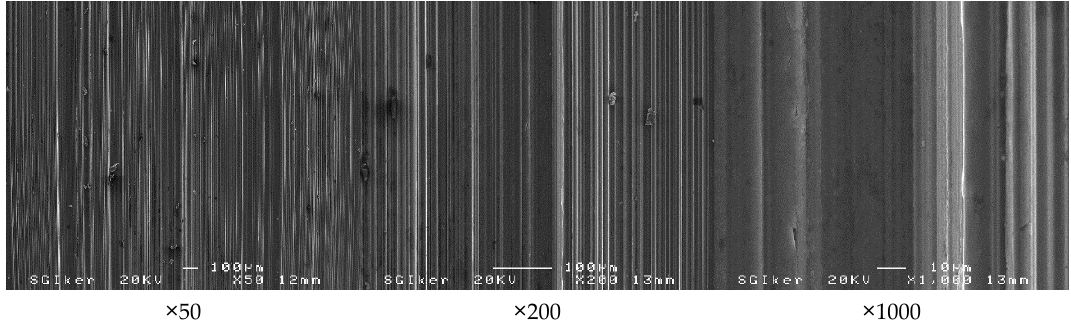
Figure 19. AA ‐ 5754 ‐ O disk. Figure 19. AA-5754-O disk.